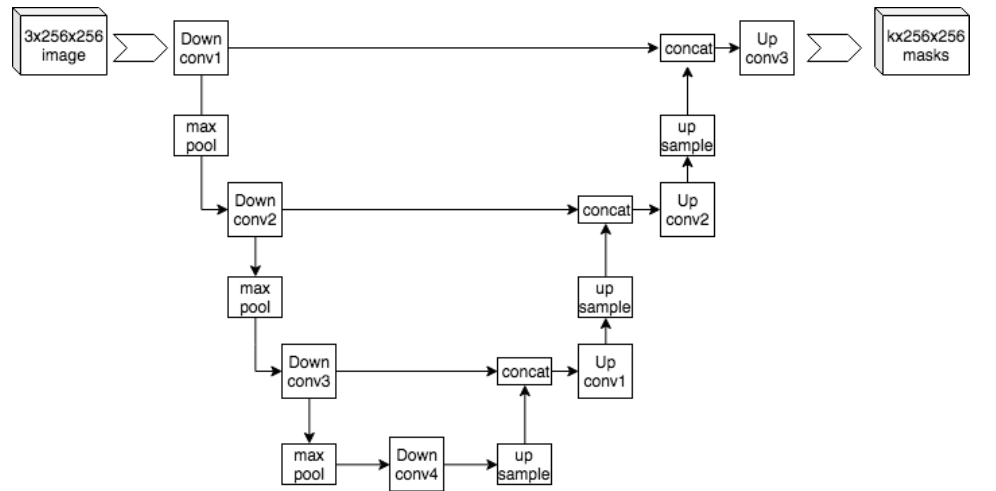
Figure 8. The customised U-Net architecture for aircraft engine defect segmentation.